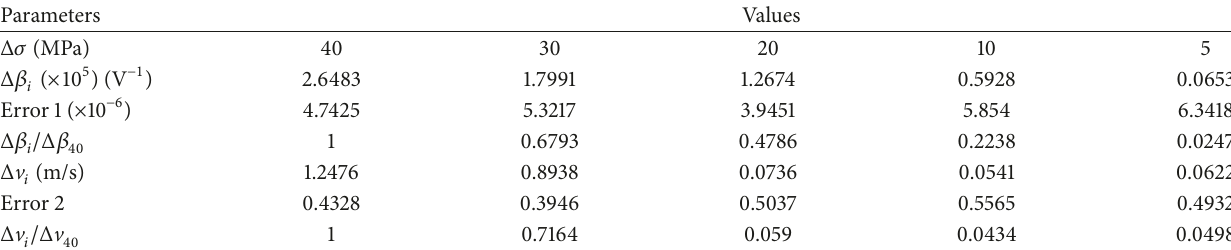
Table 2: The experimental result of stress detection resolution for grade 45